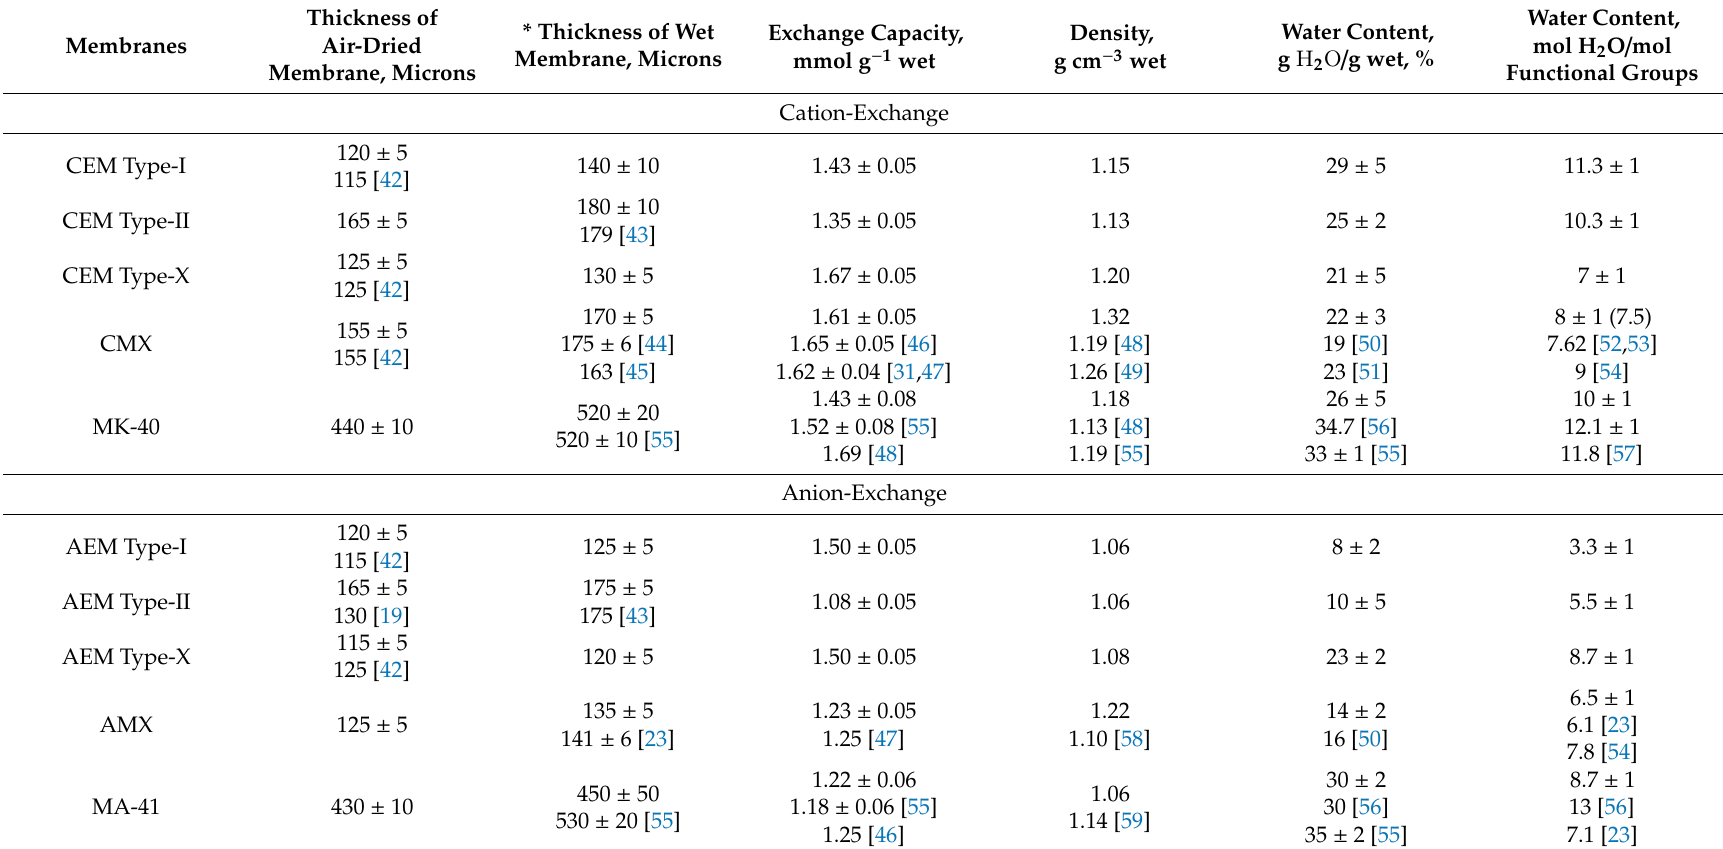
Table 2. Some of the characteristics of the membranes under study. Our data are given without reference.